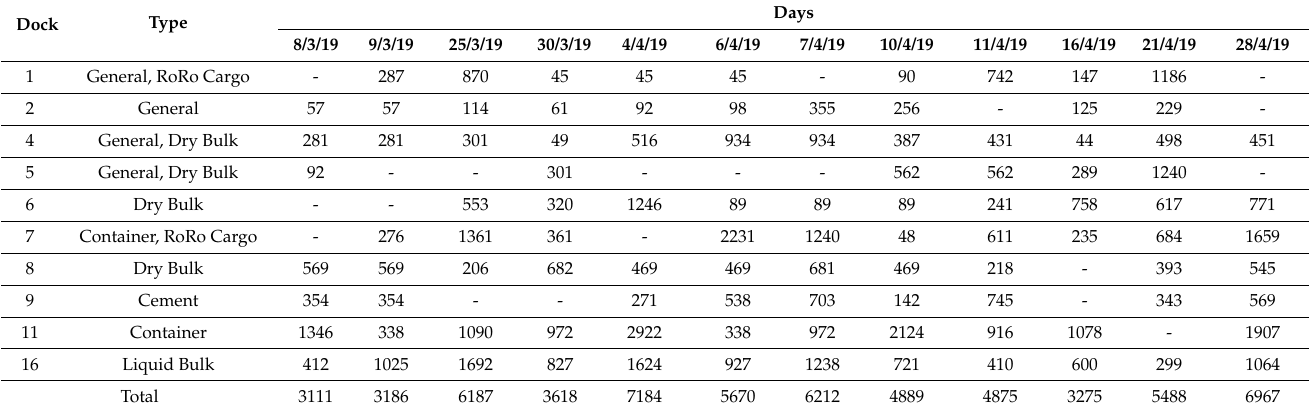
Table 4. Atmospheric emission (kg/day) by type of vessel for the days selected in CALPUFF.